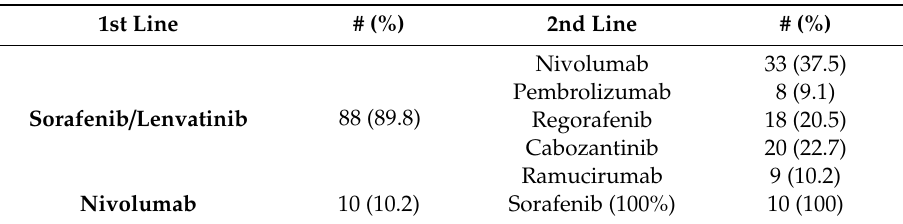
Table 1. First and subsequent second-line